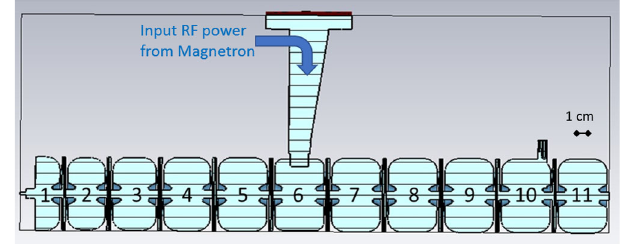
FIG. 3. 3D rendering of the coupled-cavity linac. The input rf waveguide (WR284) is matched to the linac through a tapered section.